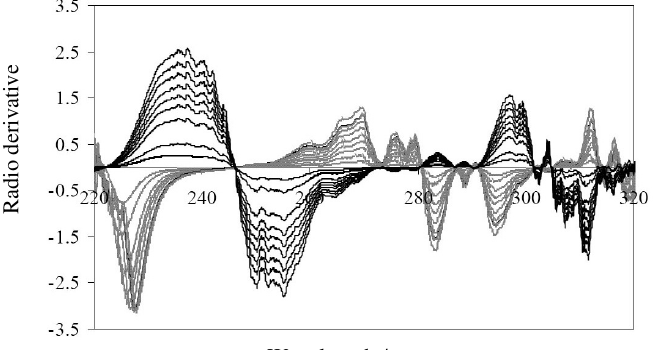
Figure 3. Ratio spectra for different concentrations of naphazoline (10, 20, 30, 40, 50, 60, 70, 80, 90 and 100 µ mol L -1 , continuous lines 1 to 10, divisor ANT, 40 µ mol L -1 ) and of antazoline (10, 20, 30, 40, 50, 60, 70, 80, 90 and 100 µ mol L -1 , dashed lines 1 to 10, divisor NAP, 10 µ mol L -1 )